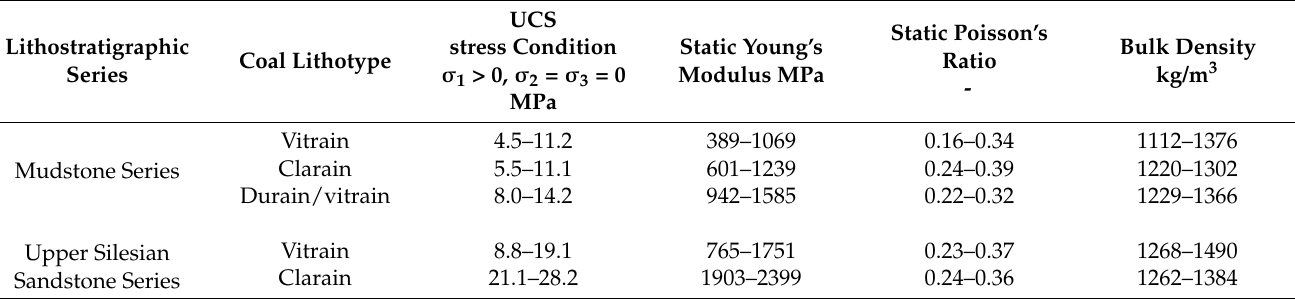
Table 5. Variability thresholds of the (mean) mechanical parameters of coal: static testing.